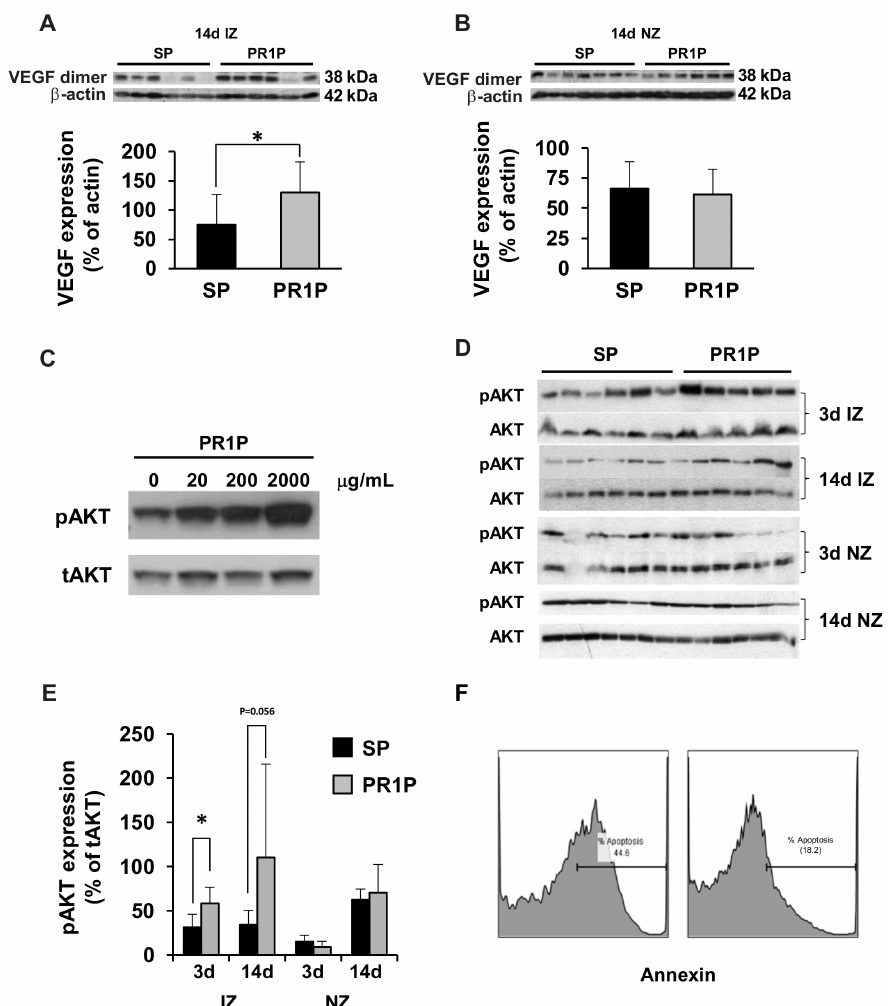
Figure 3. PR1P targets, stabilizes and upregulates endogenous VEGF within ischemic myocardium. ( A , B ) Representative Western blot analyses (at top) and corresponding bar graphs showing quantifi- cation of blots of rat heart tissue homogenates from ischemic zone (IZ, A ) or normal zone (NZ, B ) at 14 days following left coronary artery ligation and every other day intraperitoneal treatment with PR1P or scrambled peptide (SP). Bar graphs show the corresponding quantification of VEGF expres- sion as a percentage of β -actin expression for indicated groups of myocardial tissue homogenates and indicate that PR1P treatment augments the expression of VEGF in the IZ. * p < 0.05. ( C ) Repre- sentative Western blot analysis of protein from human cardiomyocyte cell homogenates following 15-minute incubation in vitro at 37 ◦ C in serum free cell culture media in the presence of increasing concentrations of PR1P showing dose-dependent increase in phosphorylated AKT (pAKT) relative to total AKT (tAKT). ( D ) Representative Western blot analyses ( D ) and corresponding bar graphs ( E ) showing quantification of phosphorylated AKT (p-AKT) relative to AKT (total, t-AKT) of rat heart tissue homogenates from ischemic or normal zones (IZ or NZ, respectively) at 3 or 14 days following left coronary artery ligation and treatments described in Figure 3A. Membranes were immunoblotted with antibodies to phosphorylated AKT (p-AKT) and then AKT (total, t-AKT) in order to quantify the relative expression of pAKT as a percentage of tAKT. ( E ) Bar graphs showing corresponding quantifications of pAKT expression as a percentage of tAKT in IZ and NZ myocardium at indicated time points showing increased pAKT in IZ following PR1P therapy. * p < 0.01. ( F ) Repre- sentative FACS analysis of cardiomyocytes following 48-hour serum starvation in the presence or absence of PR1P (0.2 mg/mL) and stained with FITC-annexin V showing that PR1P reduces serum starvation-induced